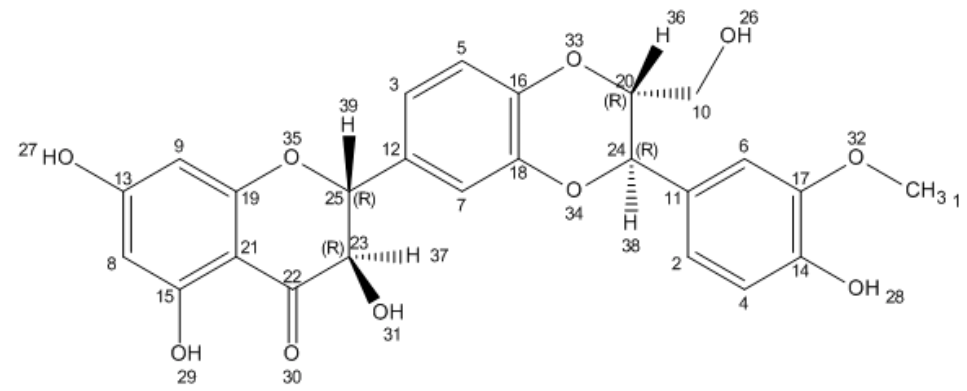
Figure 2. Chemical structure of silybin. Structure generated from InChI code from http://pubchem.ncbi.nlm.nih.gov/.